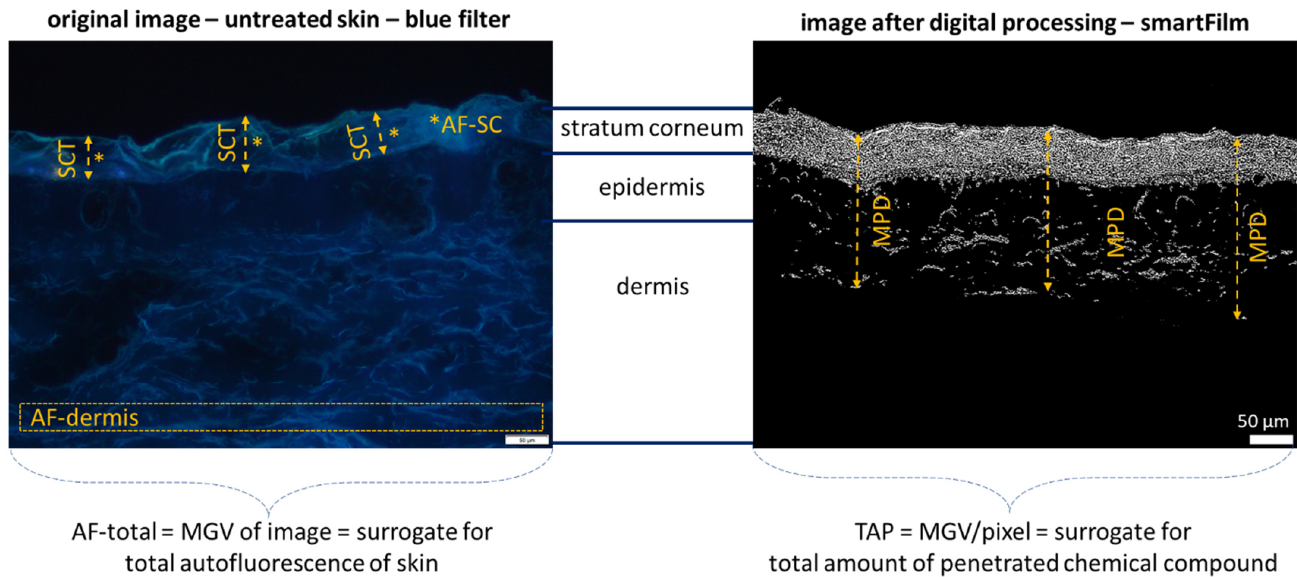
Figure 2. Microscopic images (magnification 200-fold) of untreated skin ( left , unprocessed) and skin treated with curcumin-loaded smartFilms ( right , after digital processing), visualizing the values obtained from digital image analysis. SCT = stratum corneum thickness, AF-SC = autofluorescence stratum corneum, AF-dermis = autofluorescence of the dermis, MPD = penetration depth of the chemical compound. In addition, the MGV of the whole images were measured. The MGV of the images of the untreated skin represents the autofluorescence of the whole skin (AF-total), and the MGV from the digitally processed images surrogates the total amount of penetrated chemical compound (TAP). SCT, AF-SC, AF-dermis and AF-total were assessed from the original images of untreated samples. TAP and MPD were obtained from digitally processed images treated with the respective